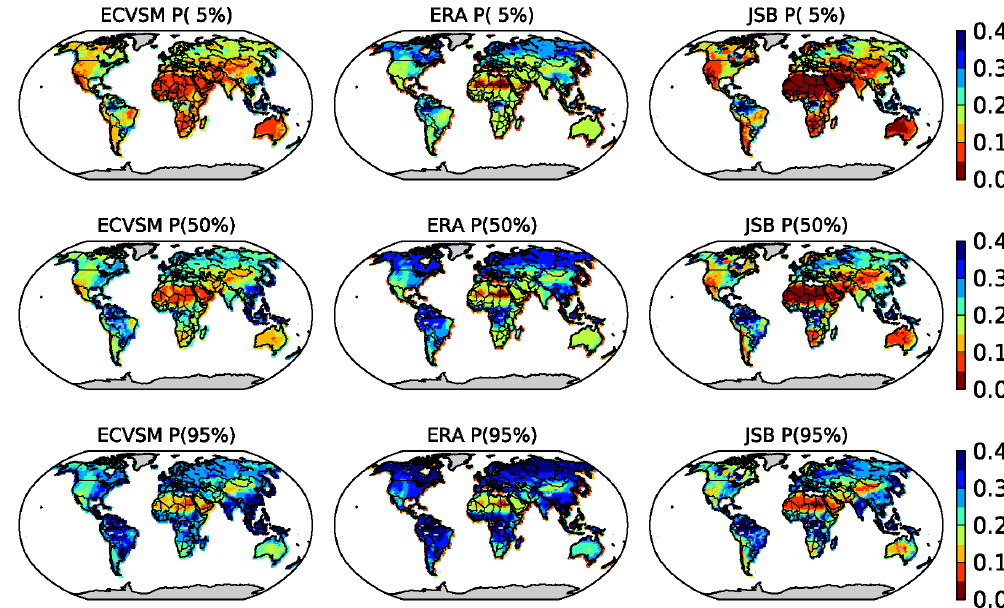
Fig. A1. Soil moisture percentiles [m 3 m − 3 ] for ECVSM (left panels), ERA-interim (middle panels) and JSBACH (right panels) for three different percentiles of p =(0.05, 0.5, 0.95) (top-down panels).